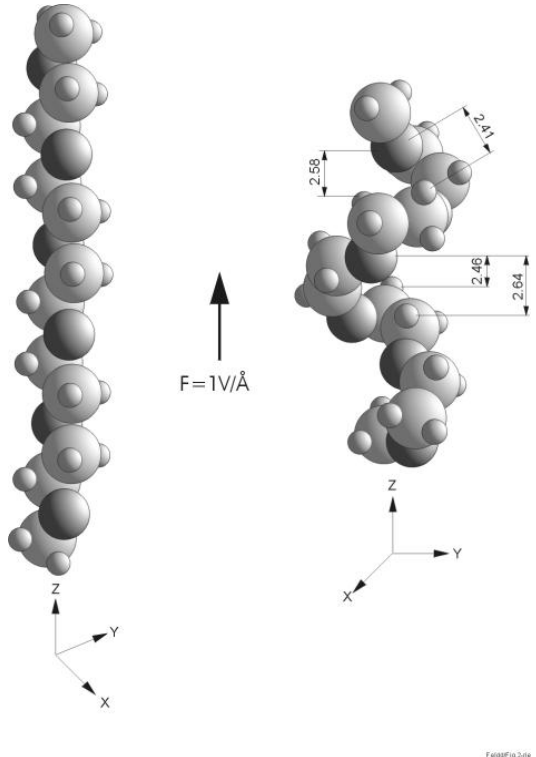
Figure 5. PEG molecule with 5 EG repeat units, planar and helical conformers in a field of 1 V/Å showing electrostriction in the